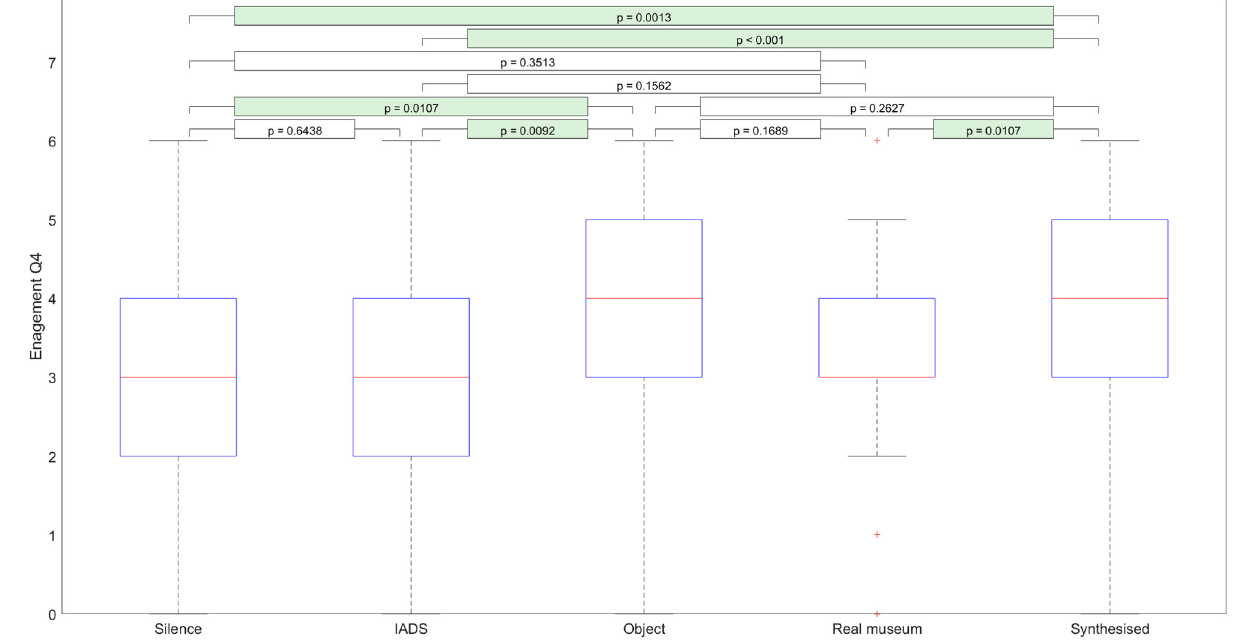
Fig 2. The effect of “object type” on the answers participants gave to “Engagement